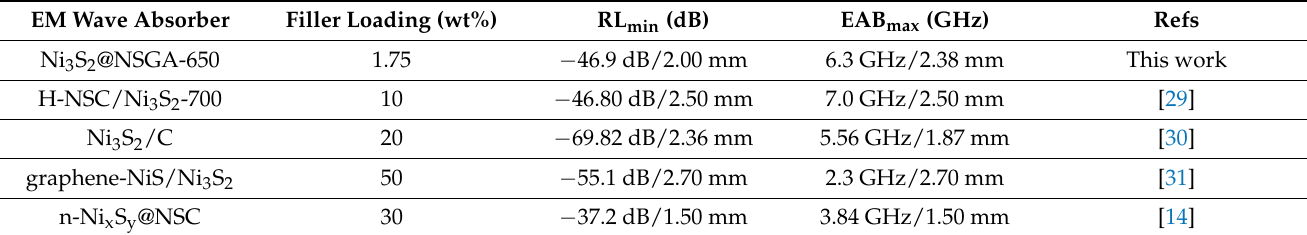
Table 1. Comparison of EM absorption performance between Ni 3 S 2 @NSGA-650 and the reported Ni 3 S 2 -based